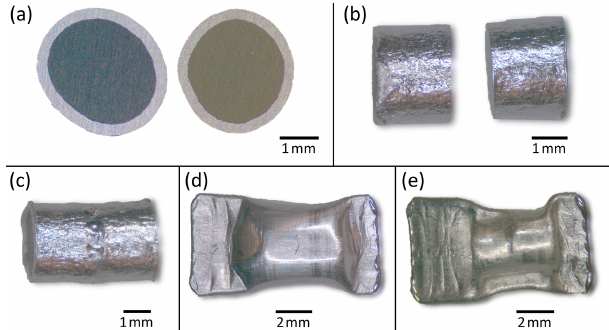
Figure 1. Photomicrographs of (a) glass cylinders with their lapped surfaces facing upward (encased by Pt capsule; the glass on the right side is affected by quench crystallization), (b) Pt-jacketed glass cylinders with their lapped surfaces facing against each other, (c) a welded diffusion couple (see welding points in the central area), (d) diffusion couple placed in a larger Pt capsule and (e) Pt cap- sule with diffusion couple after pressurization in the hydrothermal autoclave at